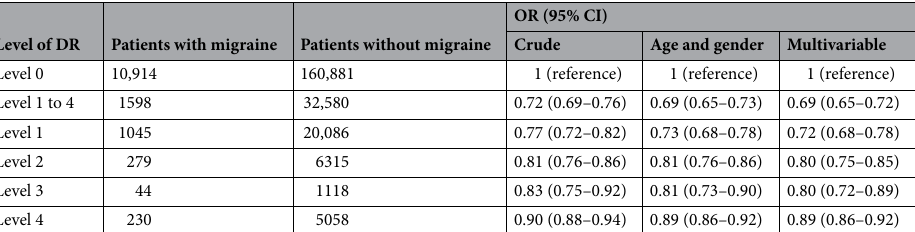
Table 2. Prevalent migraine in patients with diabetes according to level of diabetic retinopathy. Odds ratio (OR) with 95% confidence interval (CI) for prevalent migraine for patients with diabetes mellitus screened for diabetic retinopathy (DR) at the time of the index date according to level of DR (level 0 used as reference). CI confidence interval. Level of DR given by the worse eye. Multivariable model adjusted for sex, age, marital status, use of lipid lowering drugs and Charlson comorbidity index: myocardial infarct, congestive heart failure, cerebrovascular disease, chronic pulmonary disease, connective tissue disease/rheumatologic disease, ulcer disease, mild liver disease, hemiplegia/hemiplegia or paraplegia, any malignancy (including leukemia and lymphoma), moderate-severe liver disease, solid metastatic tumor, and acquired immunodeficiency syndrome.